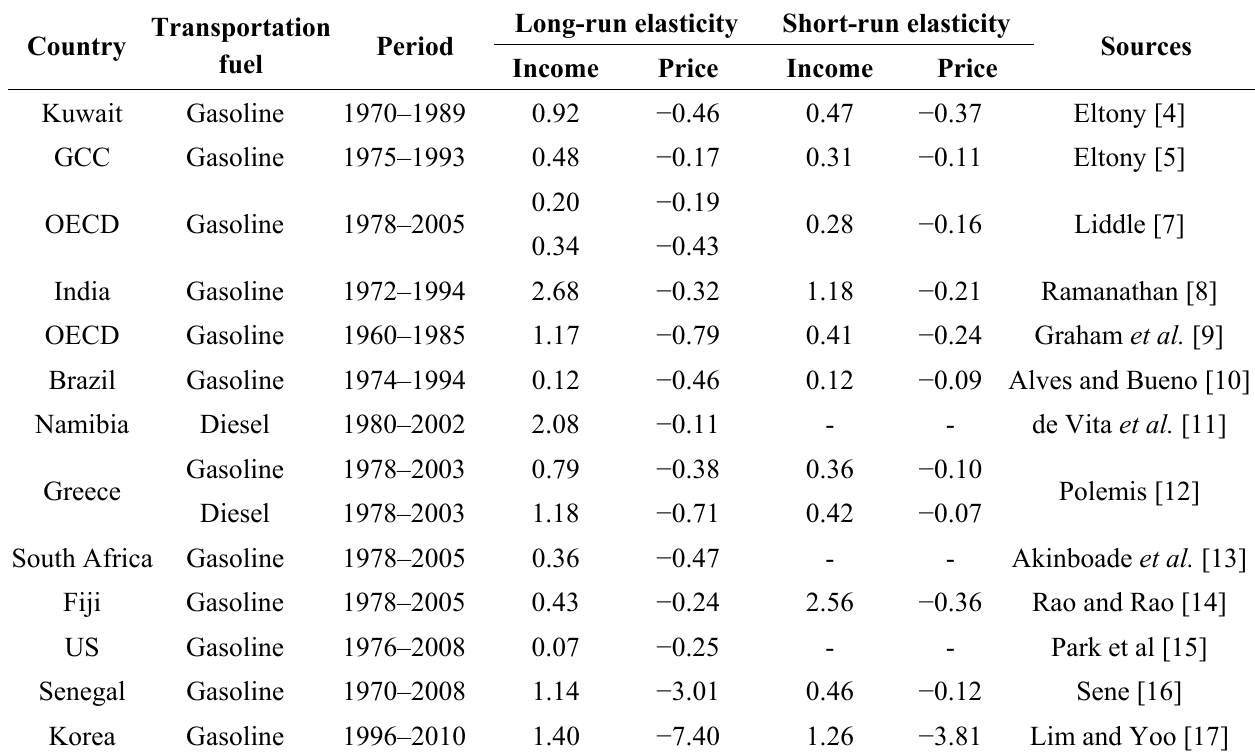
Table 2. Literature review on estimates of the elasticities of gasoline and diesel